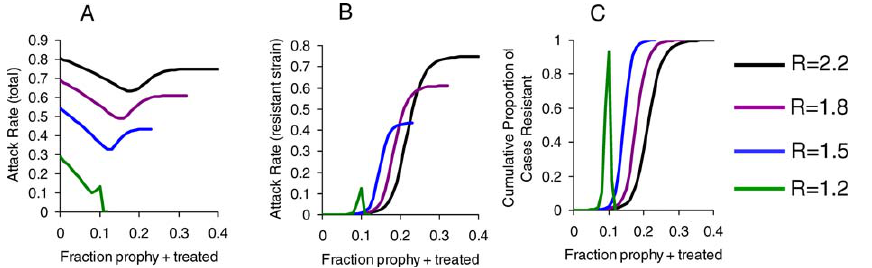
Figure 3. Effect of Varying Effective Reproductive Numbers (R E ) and of Antiviral Use on Total Attack Rate, Attack Rate of the Resistant Strain, and Proportion of All Cases Attributable to the Resistant Strain More-effective nondrug interventions reduce the attack rate while increasing the role of the resistant strain; intermediate levels of antiviral use minimize the attack rate. For combinations of interventions leading to effective reproductive numbers near unity, the epidemic may take an unrealistically long time (three or more years). Prophy, prophylaxed. (A) Total attack rate. (B) Attack rate of the resistant strain. (C) Proportion of all cases attributable to the resistant